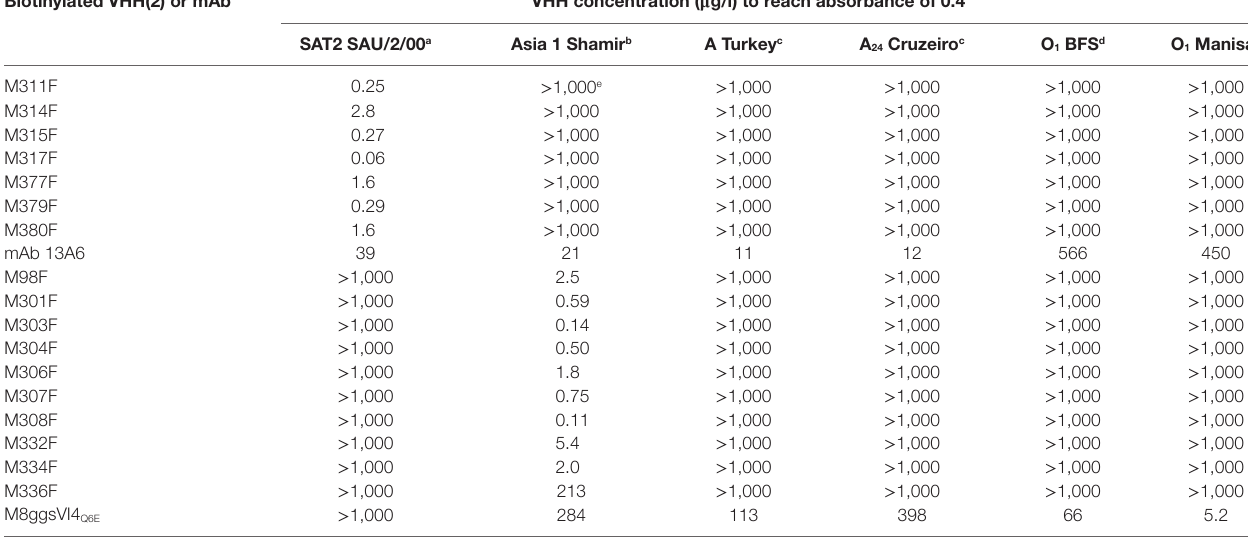
Table 4 | Binding of biotinylated VHHs to different FMDV strains. biotinylated Vhh(2) or mab Vhh concentration ( μ g/l) to reach absorbance of